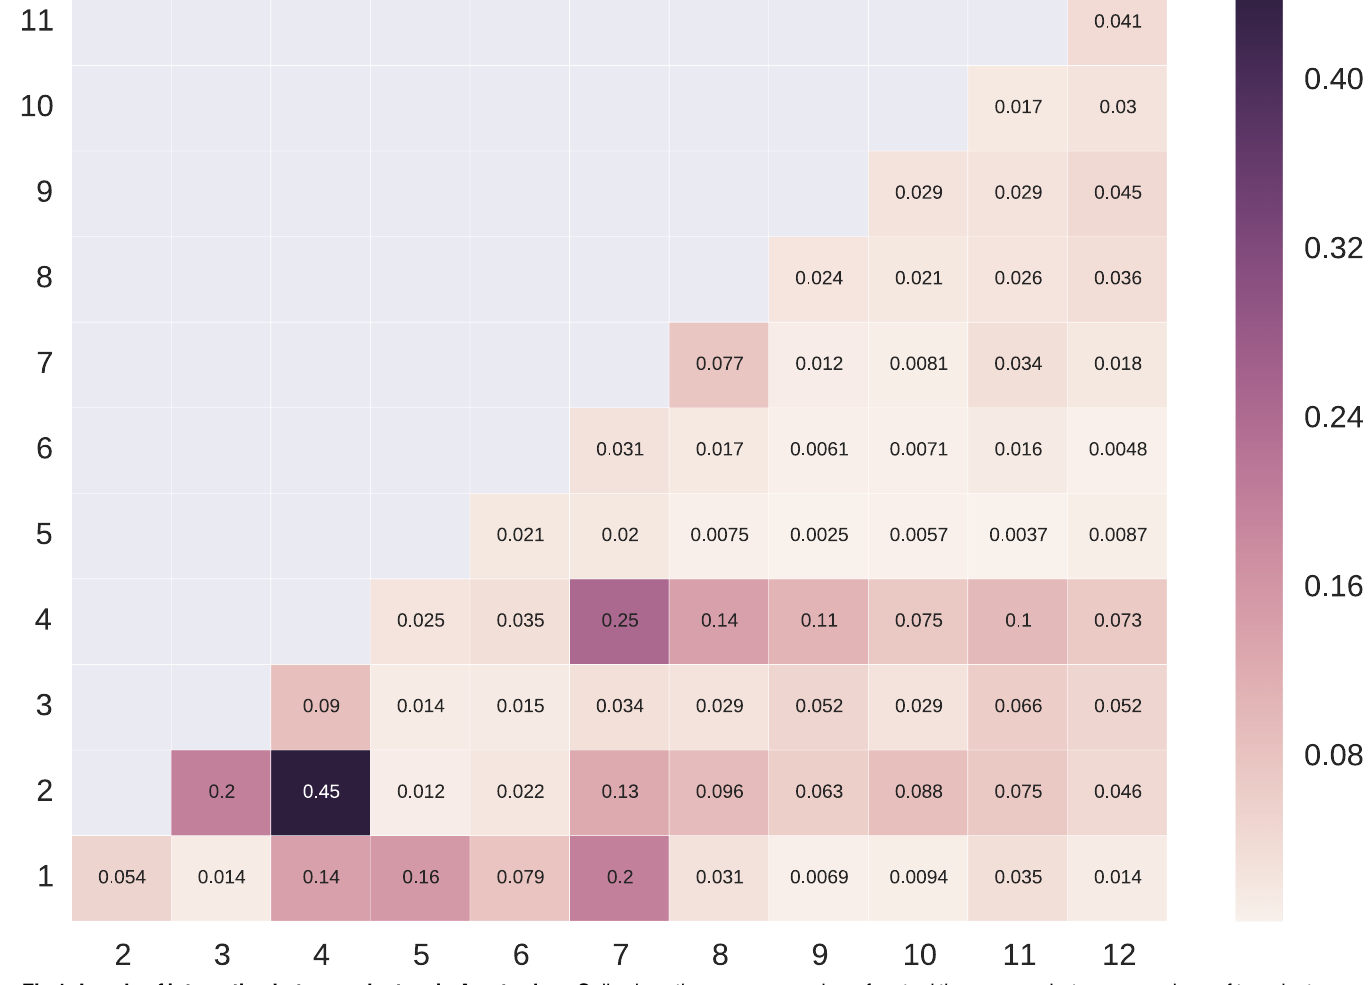
Fig 1. Levels of interaction between clusters in Amsterdam. Cells show the average number of mutual ties per user between members of two clusters. Darker shaded cells indicate a greater number of mutual ties. Blank cells indicate an absence of